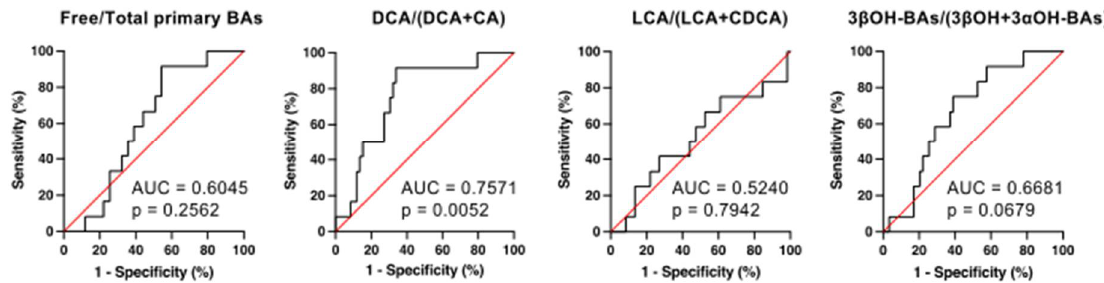
Figure 6. ROC analyses for the prediction of CDI development by serum BA markers. AUC, area under the curve. Sensitivity = true positive number/(true positive number + false negative number); specificity = true negative number/(true negative number + false positive number). The minimum distance from the upper left corner (0, 1) was considered the optimal cut-off value. The cut-off value of DCA/(DCA+CA) was < 0.349 in discriminating the high-risk patients with CDI before treatment with antibiotics. At this value, the sensitivity was 91.67%, the specificity was 66.10%, and the likelihood ratio was 2.704.